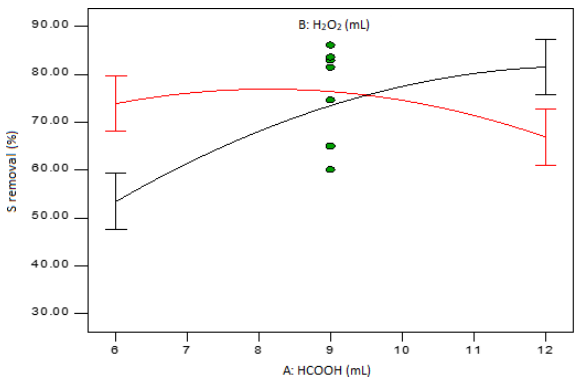
Figure 8: Interaction plot of formic acid amount and reaction time at mid-level temperature and hydrogen peroxide